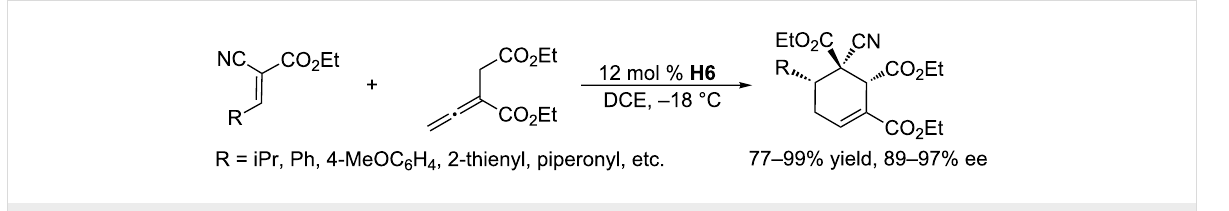
Scheme 46: Asymmetric [4 + 2] annulations catalyzed by the chiral phosphine H6